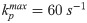
Comparison of membrane deformations between progressive versus non-progressive gel boundary.(a) In the case of non-progressive gel front, the final steady configuration is established much earlier and the final membrane elongation is smaller than a progressive gel front. Here kpmax=60s-1, Fe = 12 pN and vgmax=30nm/s for progressive gel scenario.